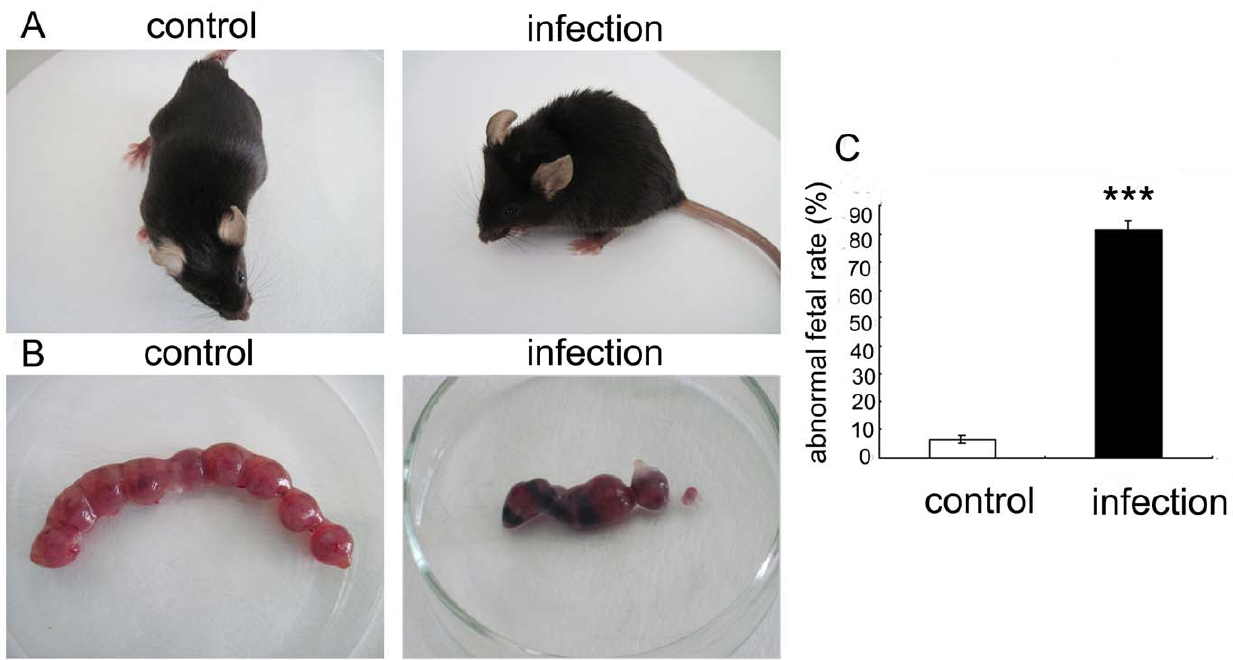
Figure 3. Pregnancy outcomes of mice following T.gondii infection. The impact of T. gondii infection on pregnant mice and their pregnancy outcome. (A) Infected mice exhibited mental and behavioral disorders and extrados, but control group appeared to be energetic. (B) Representative pictures of uteri from T. gondii -infected mice and gestational age-matched control mice 6 day post-infection (six dpi). (C) At six dpi, the abortion rate was calculated as the ratio of resorption sites to the total number of implantation sites in infected and control mice (*** p , 0.001). Data are expressed as the means 6 S.E.M., and experimental and control group each contained six mice.